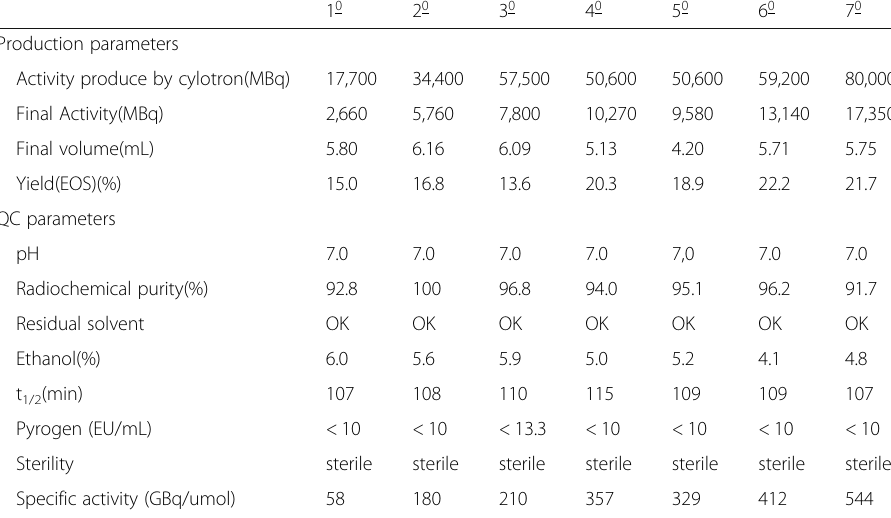
Table 3 Production and QC results of the pilot batches Production